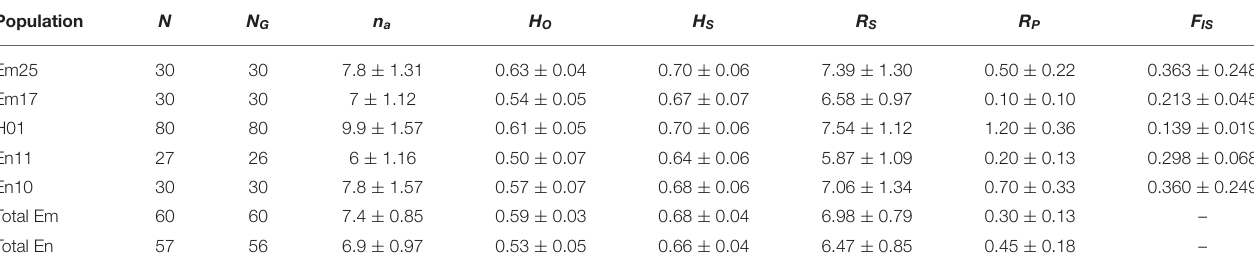
TABLE 2 | Genetic diversity parameters and effective population sizes for Erysimum mediohispanicum (Em), E rysimum nevadense (En), and the hybrid populations (total N = 197).